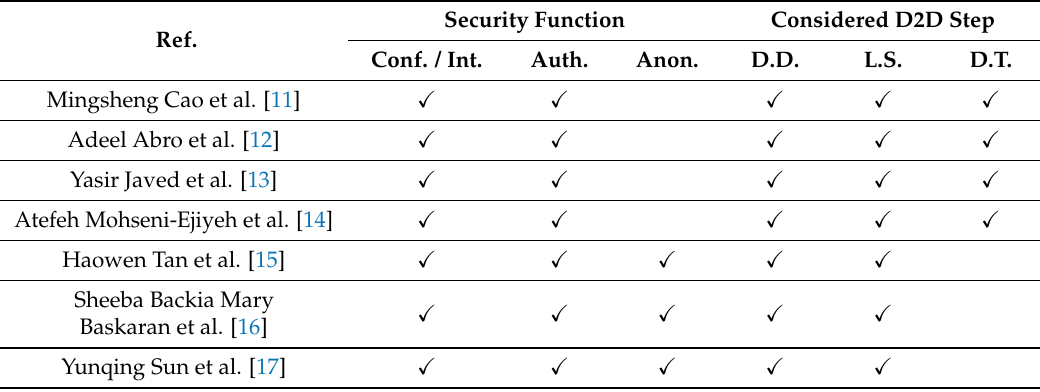
Table 1. Taxonomy of strategies of existing secure device-to-device (D2D) communication. Security Ref.